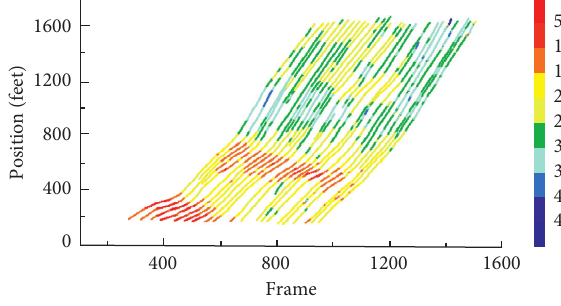
Figure 5: Vehicle track diagram (TLC).